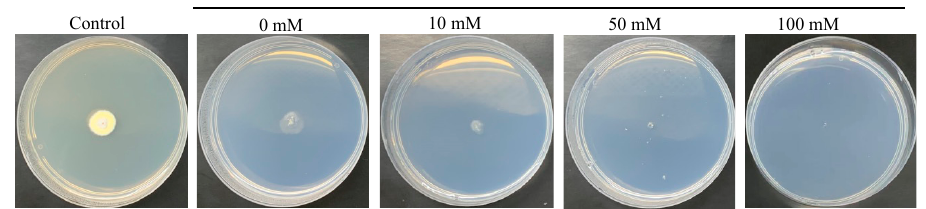
Figure 5. Growth of Spiromastix sp. SCSIO F190 on ANM plate with acetamide as sole nitrogen and carbon source. The spores of Spiromastix sp. SCSIO F190 were inoculated on the acetamide plate with different concentrations of cesium chloride and incubated at 28 °C for 10 days. The growth on the ANM plate containing glucose and ammonium tartrate was set as control.